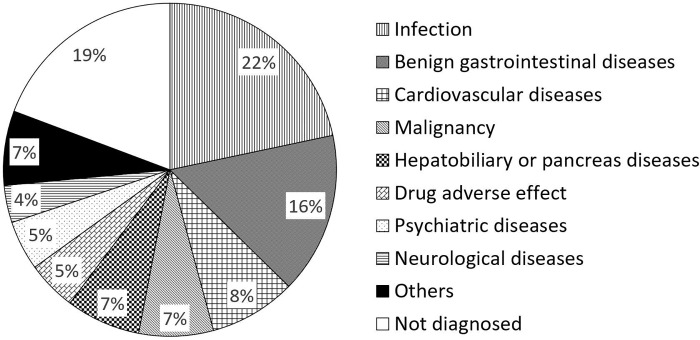
Causes of anorexia.